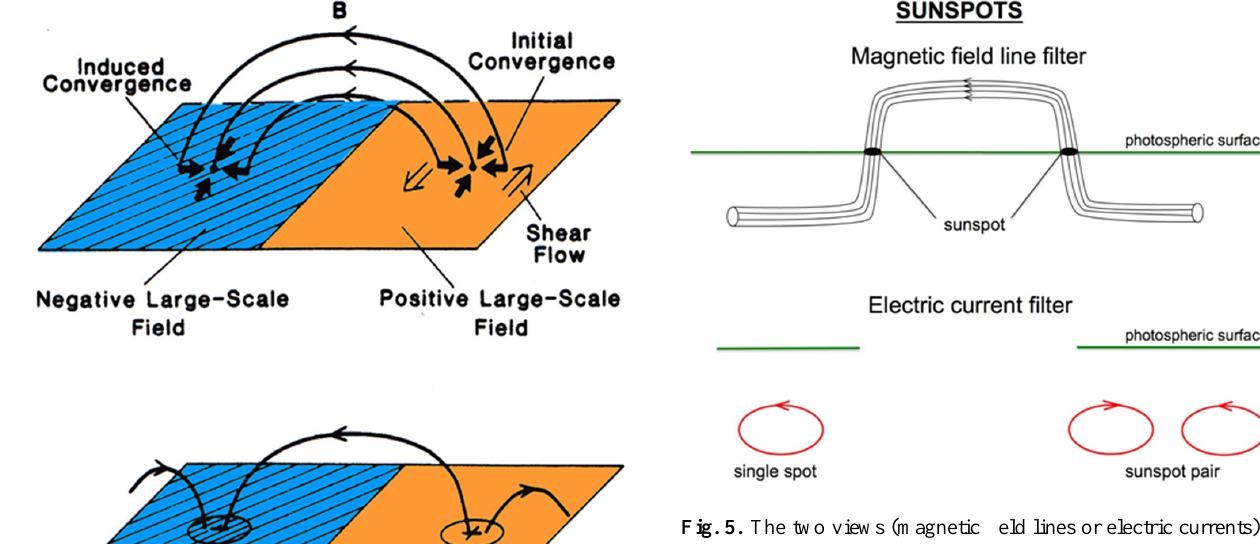
Fig. 5. The two views (magnetic field lines or electric currents) of